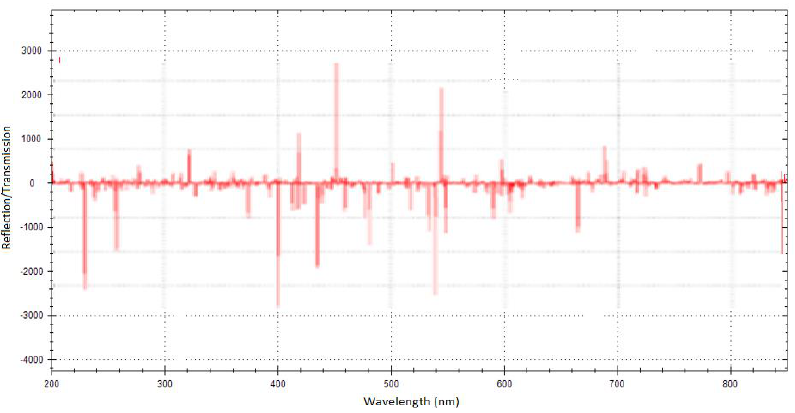
Figure 16. Spectrometer reflectance obtained from the PE pipe with a crack (right) at 2% moisture